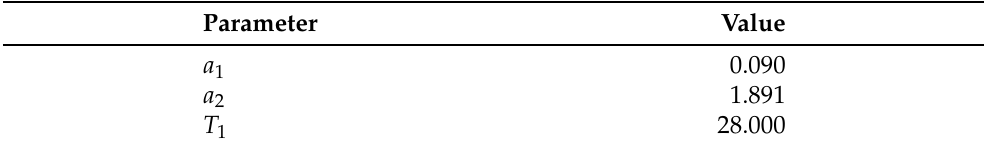
Table 3. Synergetic controller